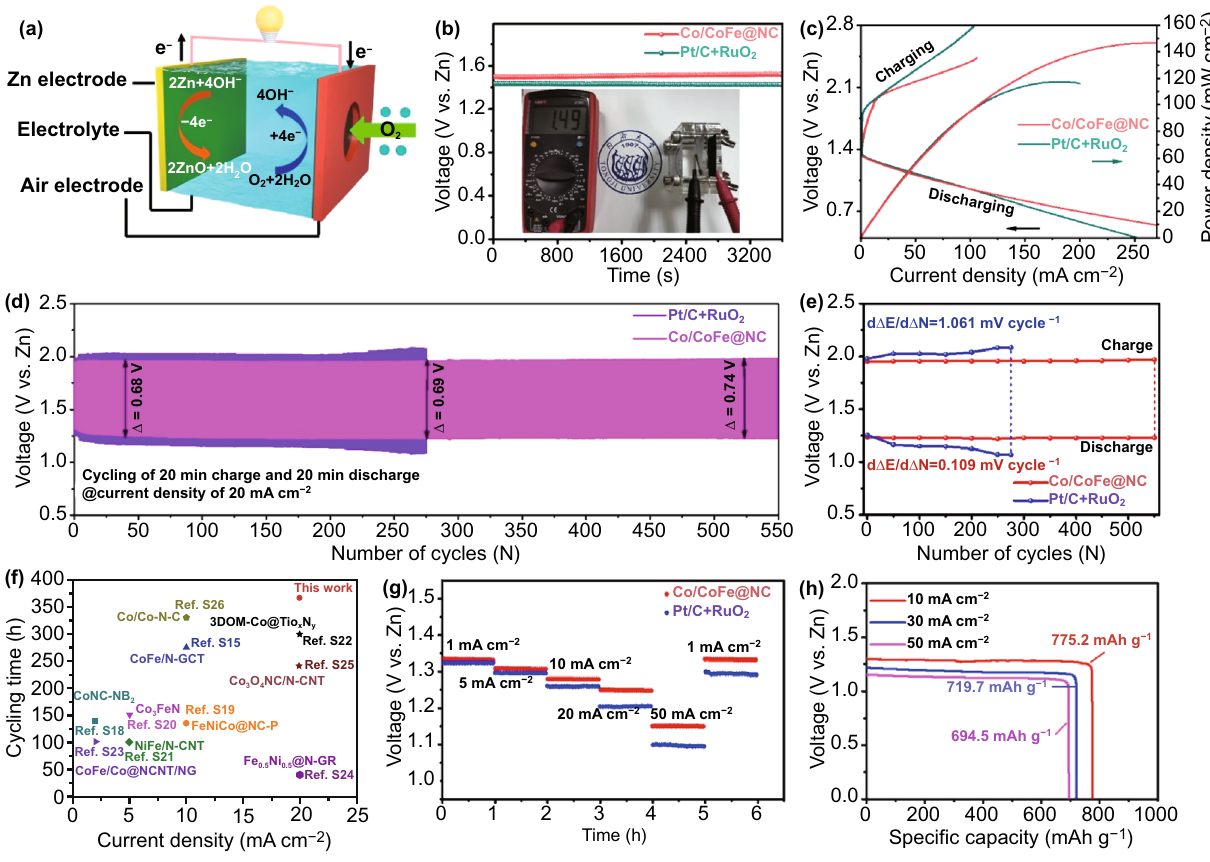
Fig. 7 a Schematic diagram of a liquid ZAB. b Open‑circuit plots, c galvanodynamic charge and discharge polarization curves and correspond‑ ing power density plots, d galvanostatic charge–discharge cycling profiles, and e voltage variation with cycles for ZABs assembled using Co/ CoFe@NC and Pt/C + RuO 2 catalysts, respectively. f Comparison of cyclability of ZABs between this work and other recently reported results. g Rate discharge curves and h specific capacity at various current